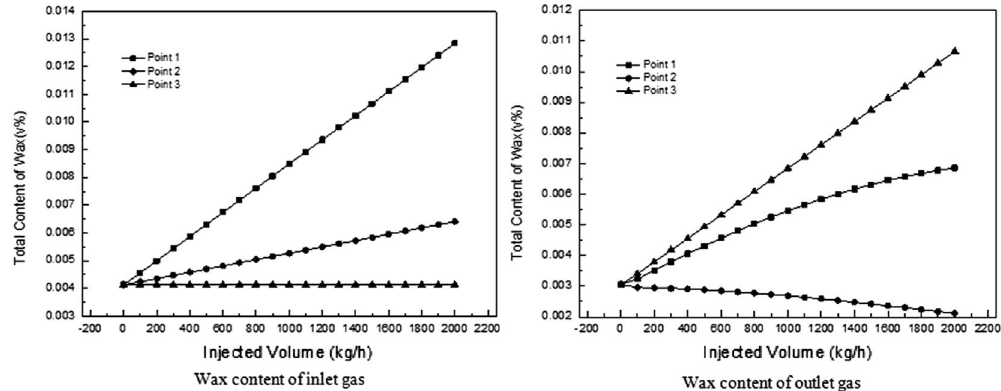
Fig. 12. The variation of wax content of inlet/outlet gas of high-pressure separator with the injected